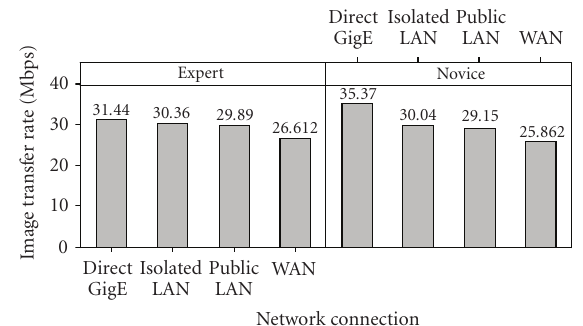
Figure 12: Image transfer rate ( b (cid:2)